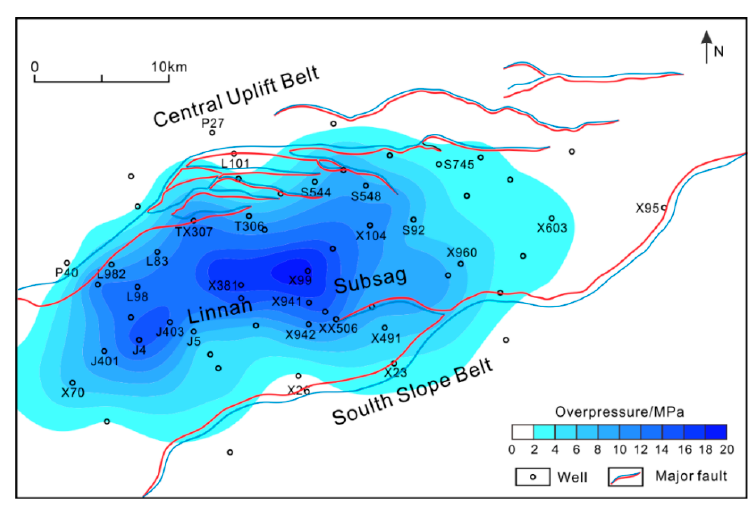
Figure 7. Distribution of the estimated overpressures in mudstone in Es3 in the Linnan Sag. The overpressure is highest in the center and gradually decreases toward the margins of the sag.